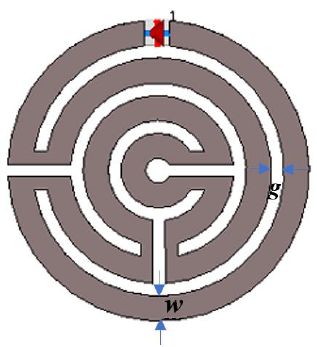
Figure 4. Geometric schematic of four-turn split-ring loop.